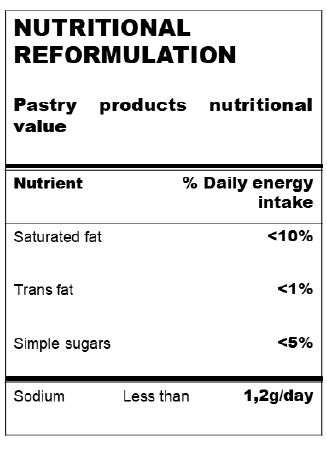
Figure 2. Recommended intake levels expressed as % of daily energy intake (kcal / day) of saturated and trans-fat and simple sugars and grams of sodium *. * Useful in pastry and bakery product